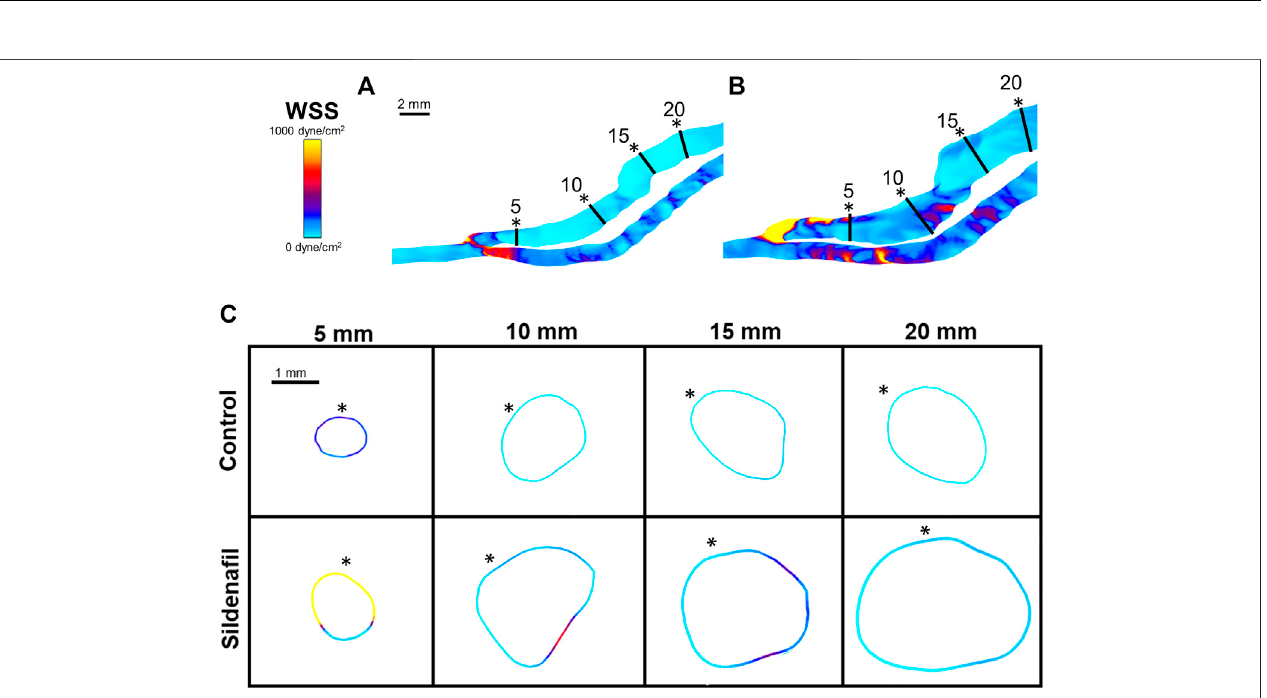
FIGURE 6| WSS color maps. (A,B) WSS for AVFs in a control rat (A) and asildena fi ltreated rat (B) . (C) Color maps of WSS for control (top) and sildena fi l(bottom) treatedratsat5,10,15,and20 mmawayfromtheanastomosis.BlacklinesinpanelsAandBrepresenttheslicelocations.*inpanelCrepresentsthetopofthesliceas shown in panels A and B. Color bar applies to (A – C) . Scale bar in A applies to (A – B) .